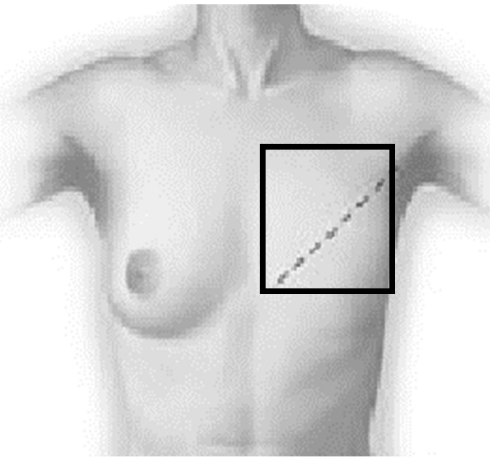
Figure 1. The scheme of the breast area drawings in all the thermograms.